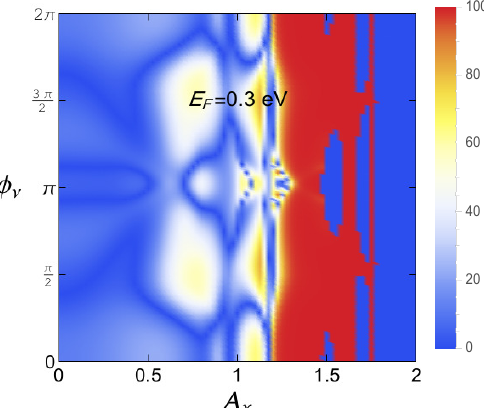
Figure 6. (Color online). Simultaneous variation (density plot) of GMR as functions of A x and AAH phase φ ν . Here, we chose E =